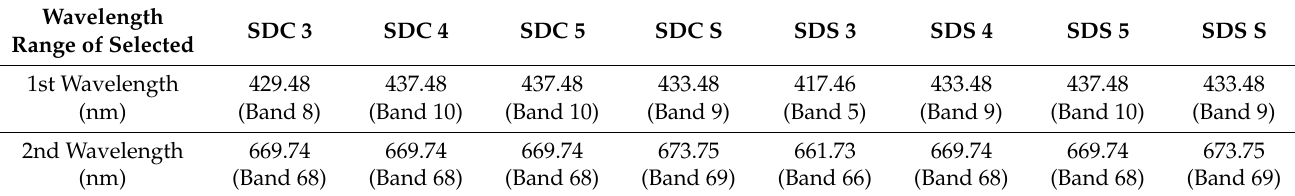
Table 3. Absorption wavelength range of selected green algae.